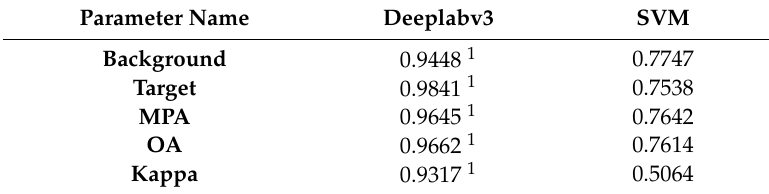
Table 7. Classification accuracy of RGB bands by Deeplabv3 and